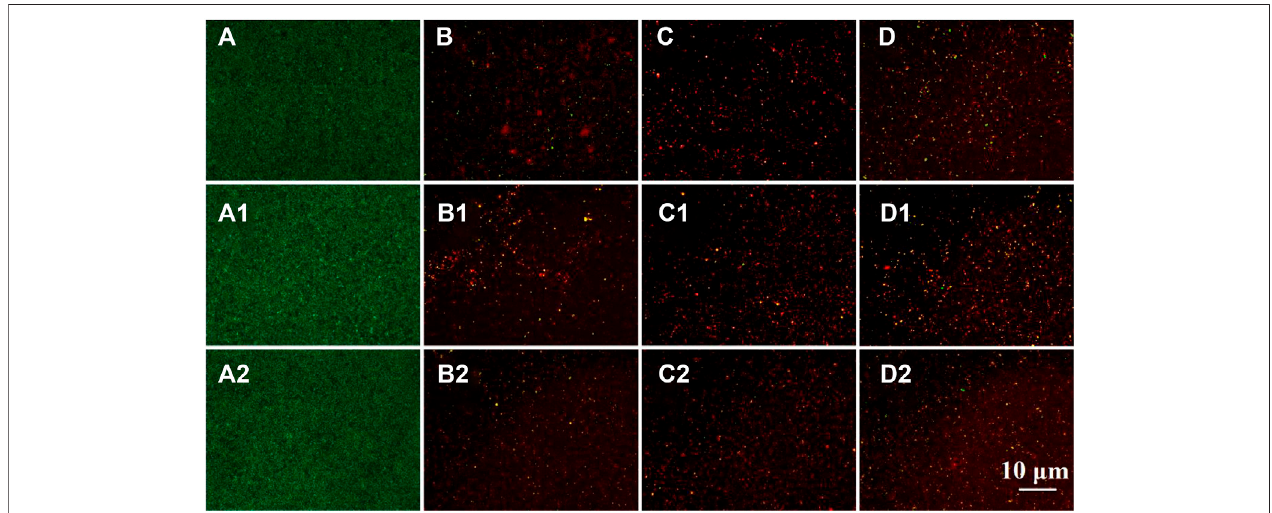
FIGURE 9 | BacLight Live/Dead Kit Assay staining of E. coli , S. aureus , and P. aeruginosa colonized on the bare coupon (A – A 2 ) , and the specimens coated with PDA/TA-ALL@CS-6 (B – B